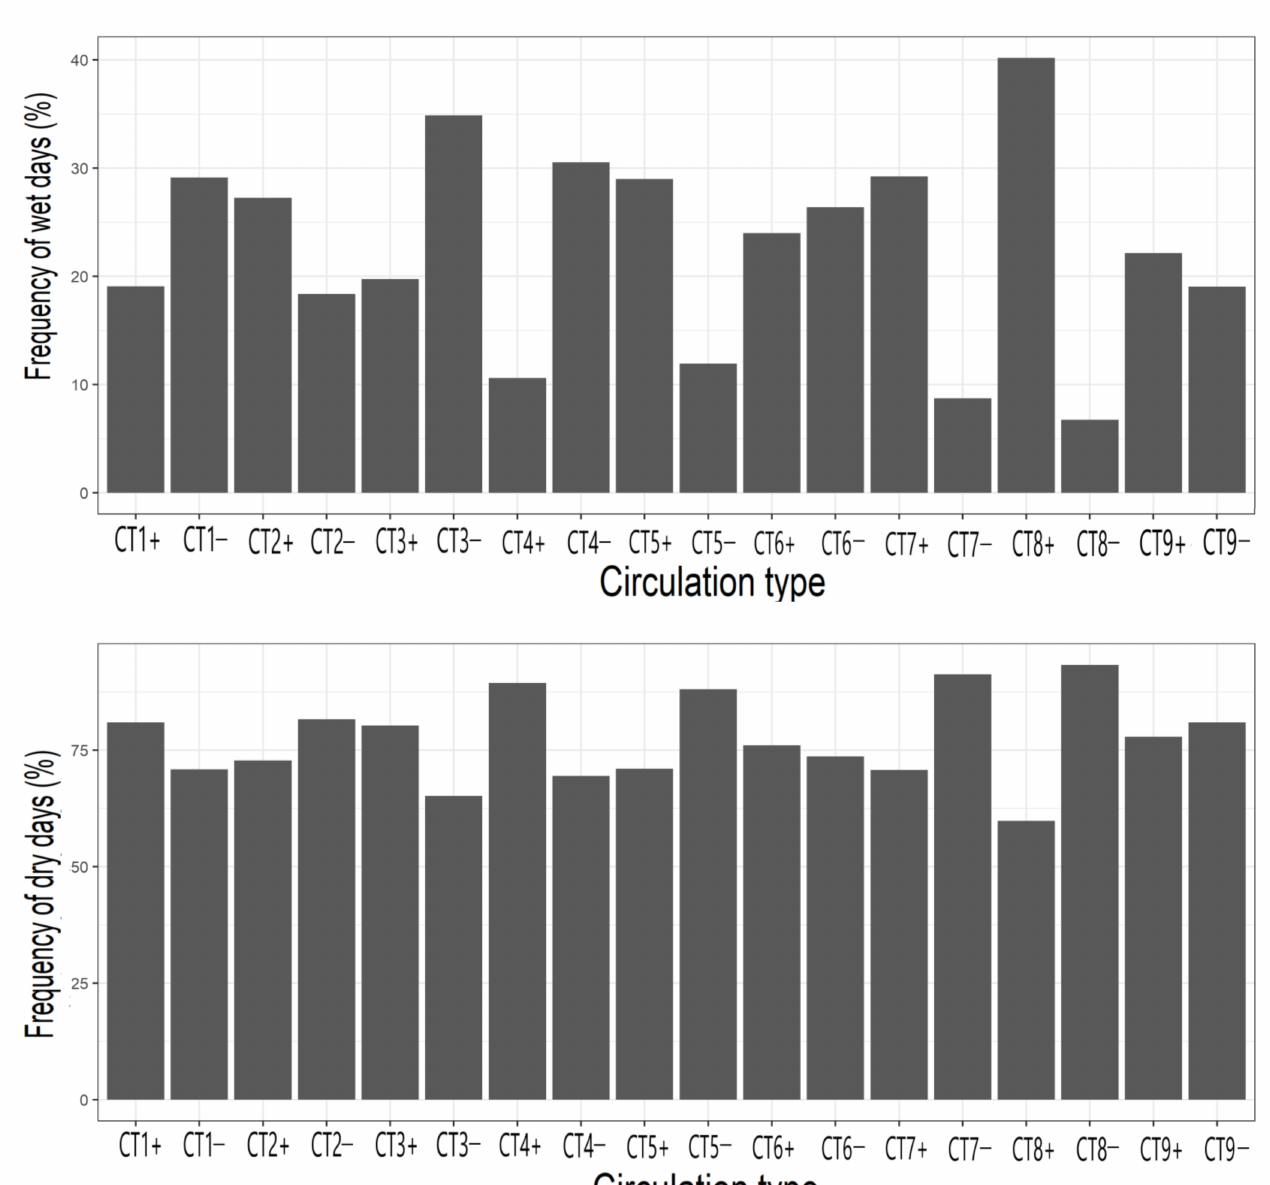
Figure 4. Probability of wet days (top panel) and dry days (bottom panel) associated with the CTs in Figure